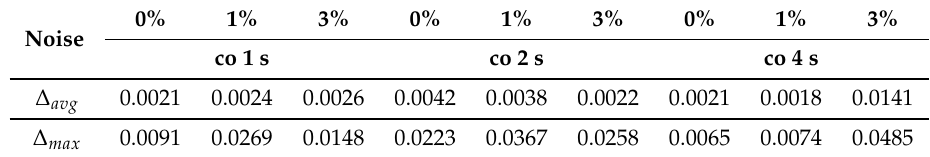
Table 3. The errors of the function u reconstruction for the measurement points in the case of four